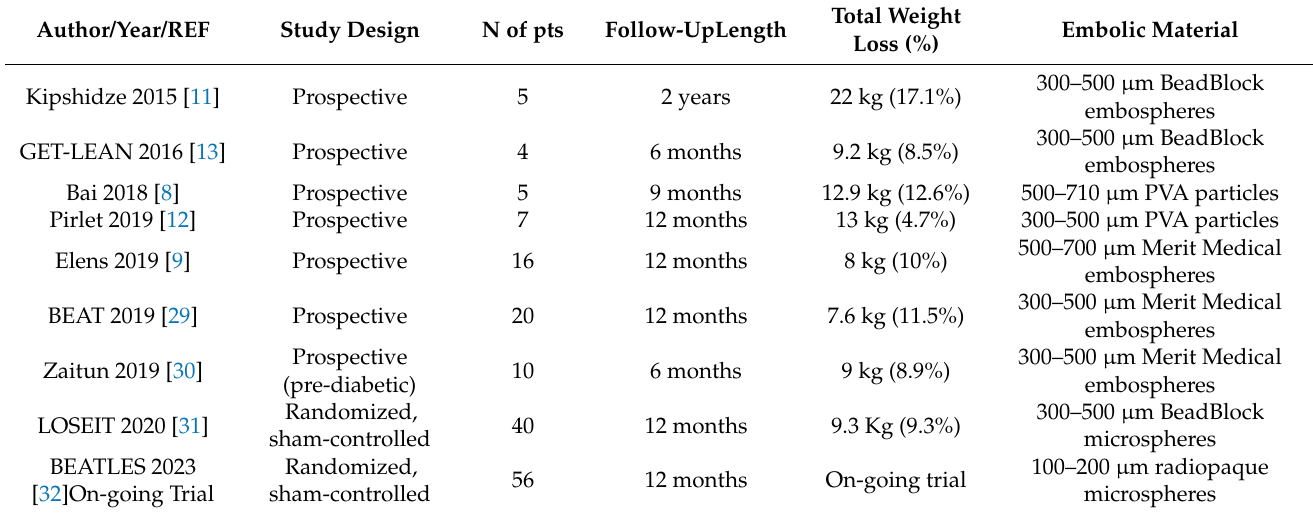
Table 2. Clinical Studies Evaluating BES procedure for Weight